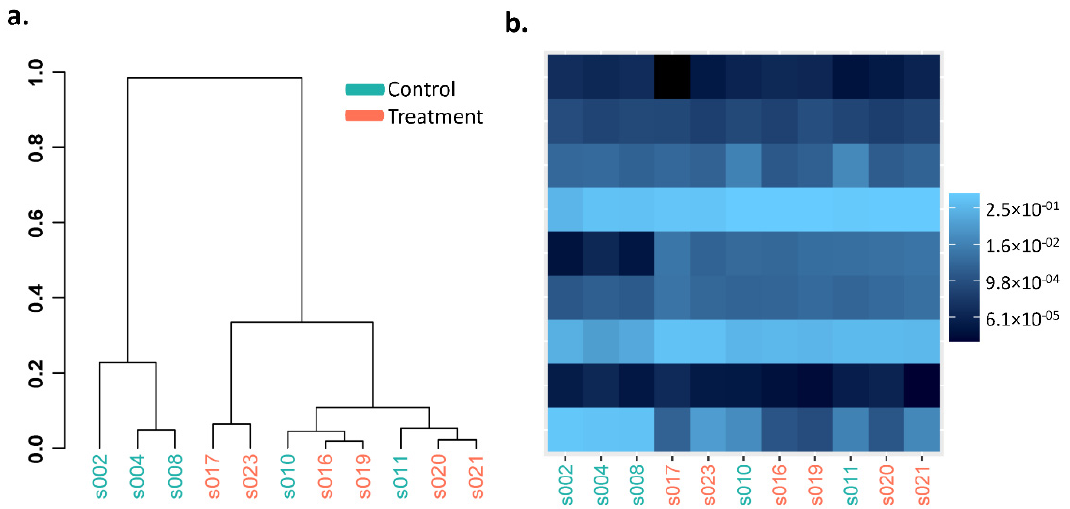
Figure 3. Phylum level Bray–Curtis dissimilarity comparisons in the GI microbiota dysbiosis (treat- ment) ( n = 6) and control ( n = 5) groups. ( a ) Hierarchical clustering, ( b ) heatmap.